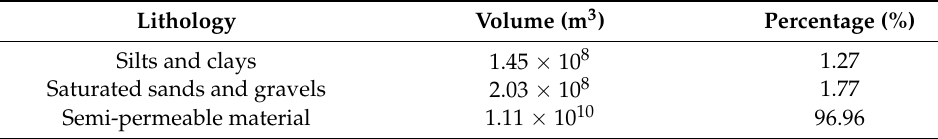
Figure 10. Volume estimation with GeoModeller software. Table 4. Results of volume estimation with GeoModeller